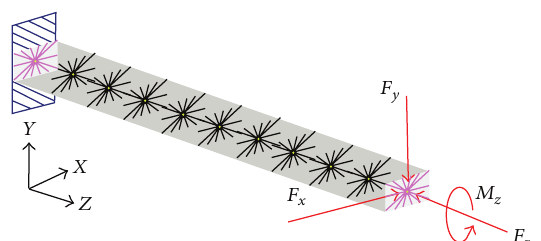
Figure 1: Application of static FE-based method: loads, constraint, and connection elements applied to the detailed 3D beam model.